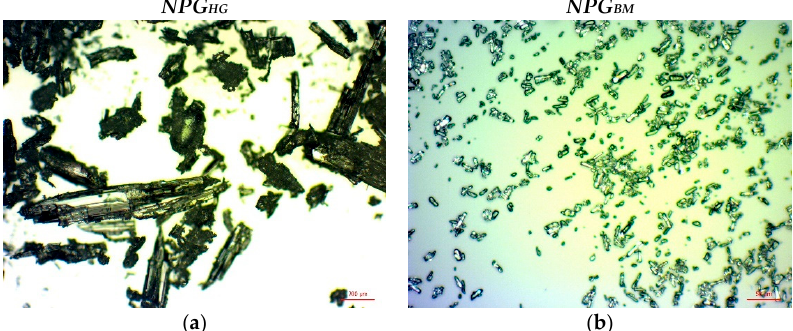
Figure 1. Optical microscope images of NPG crystals of ( a ) NPH HG and ( b ) NPG BM obtained at x5 and x20 magnification,